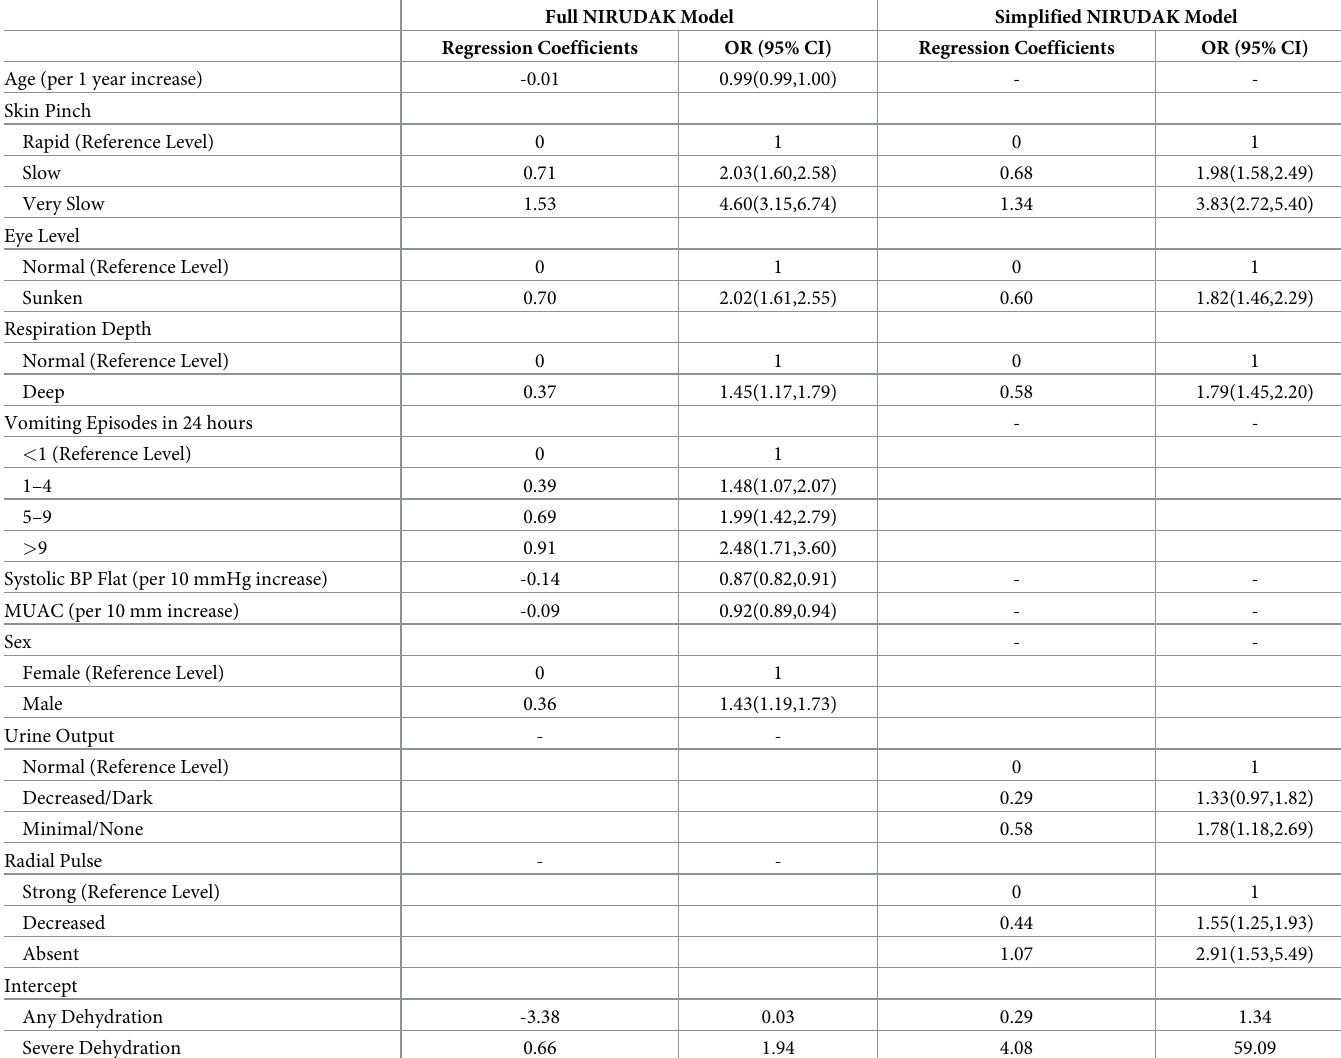
Table 5. Full and Simplified NIRUDAK